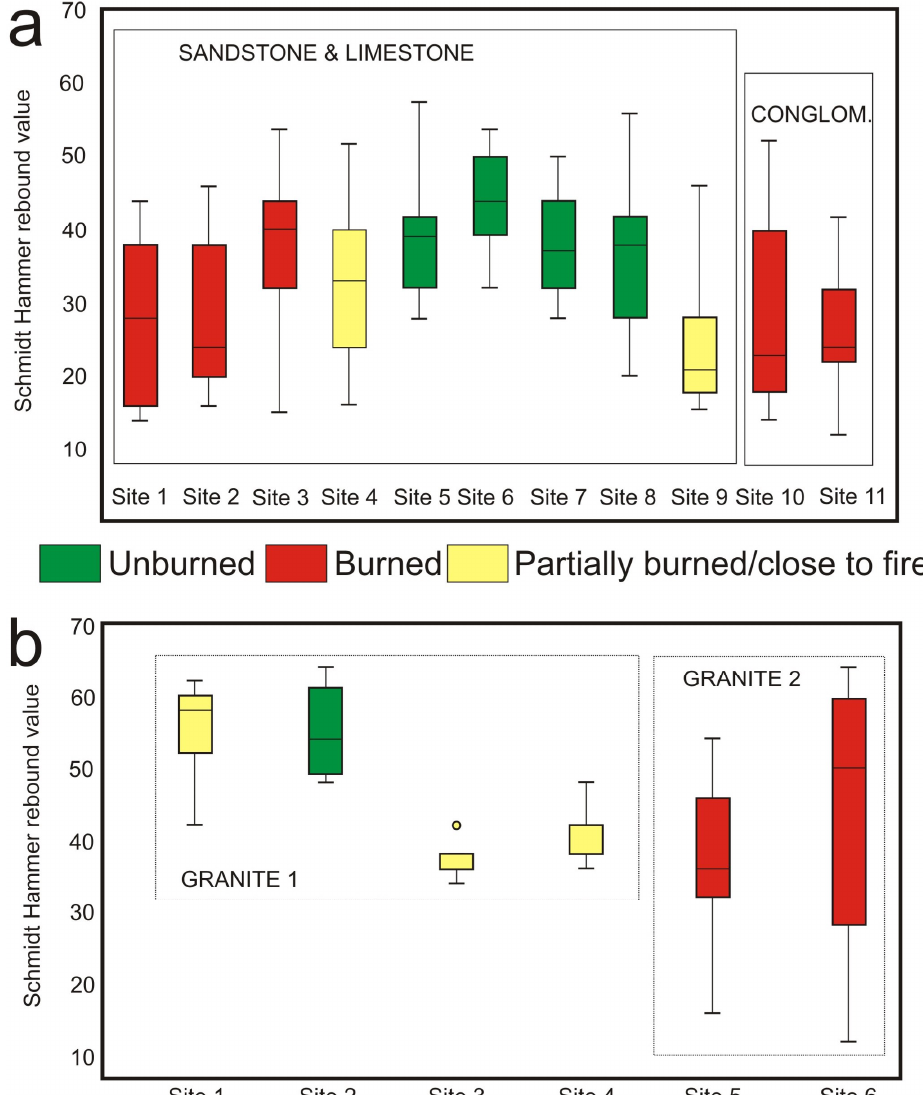
Figure 9. Schmidt Hammer (SH) values of the two studied areas: ( a ) Oliana with a clear variation of rebound values between sites visibly affected and non-affected by fire; ( b ) Cadalso de los Vidrios with two different granites along the various